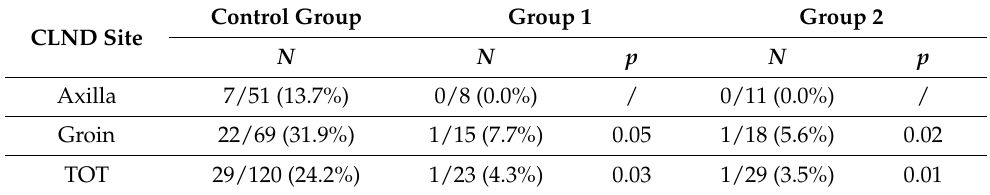
Figure 2. Kaplan–Meier curves for the cumulative risk of recurrence at 3 years. Table 2. Frequency of lymphedema. Comparison with the results of group 1, group 2 and the control group.